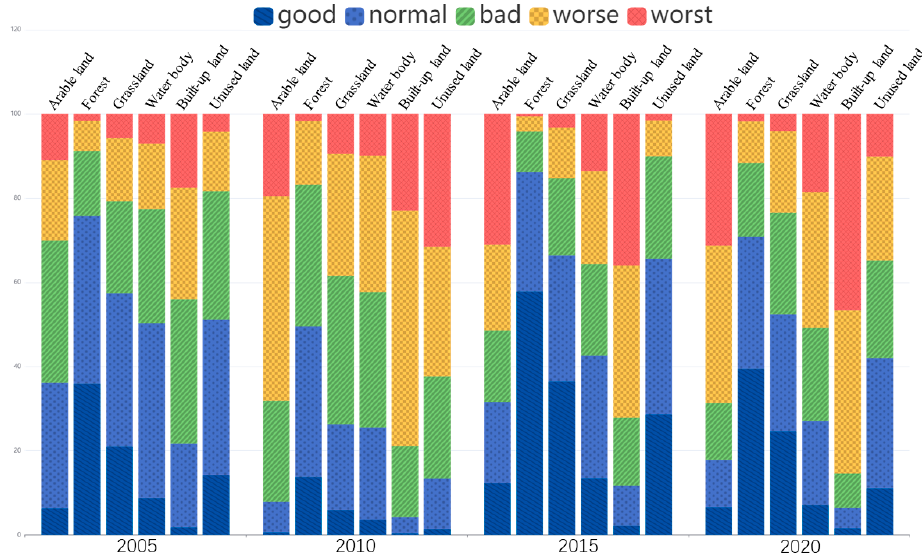
Figure 13. Proportion of UTCI of different LUCC types in YZD.